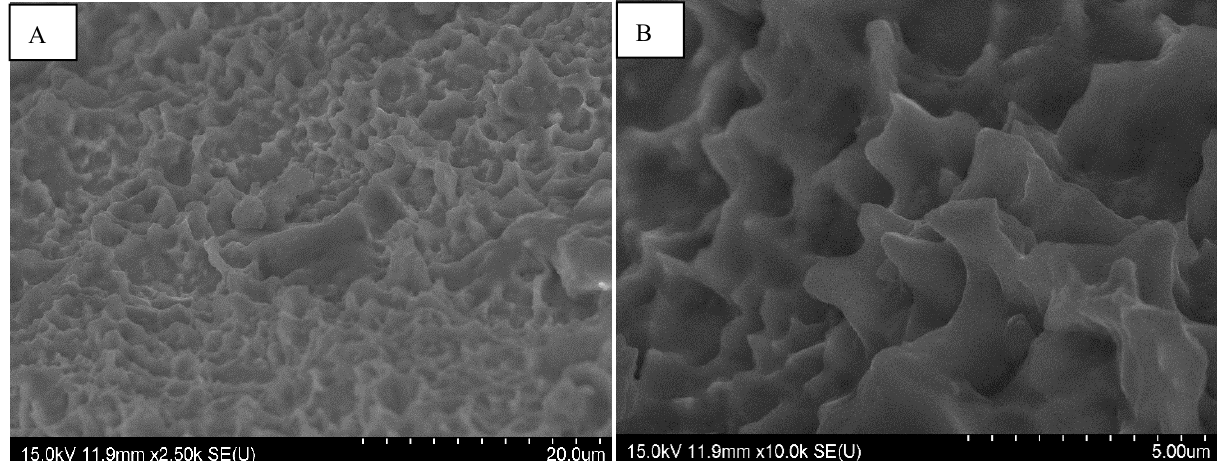
Figure 1. SEM image of the surface morphology of the Straumann ® implant showing a very regular surface area and an oriented surface roughness: magnification ×2500 ( A ) and ×10,000 ( B ).